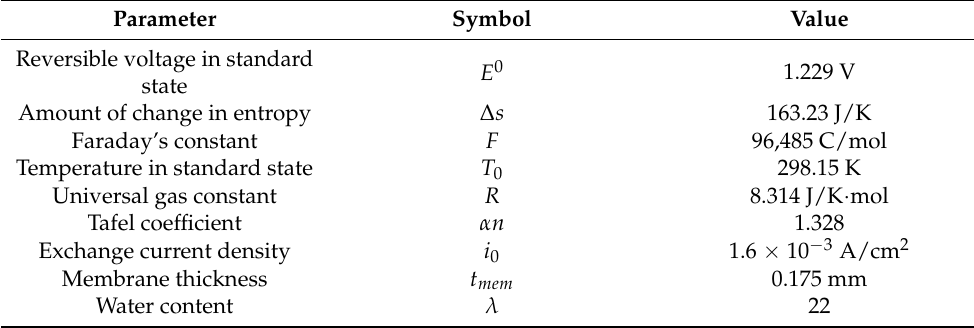
Table 2. Parameters used in the electrochemical model of the PEMWE. Parameter Symbol Value Reversible voltage in